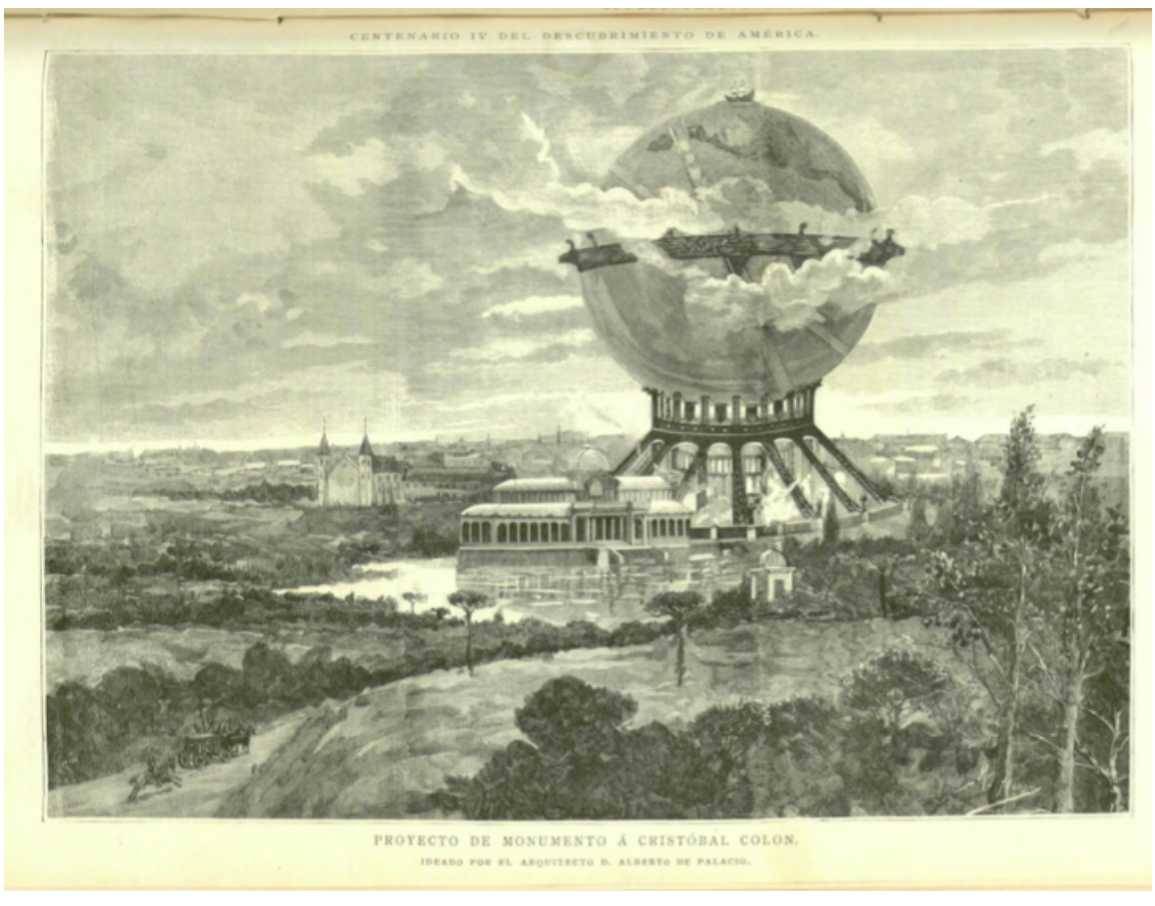
Alberto Palacio, “Proyecto de Monumento a Cristóbal Colón” [Project for the Monument to Christopher Columbus], in La Ilustración Española y Americana, year XXXV, issue XXXI, Madrid, 22 August 1891, p.